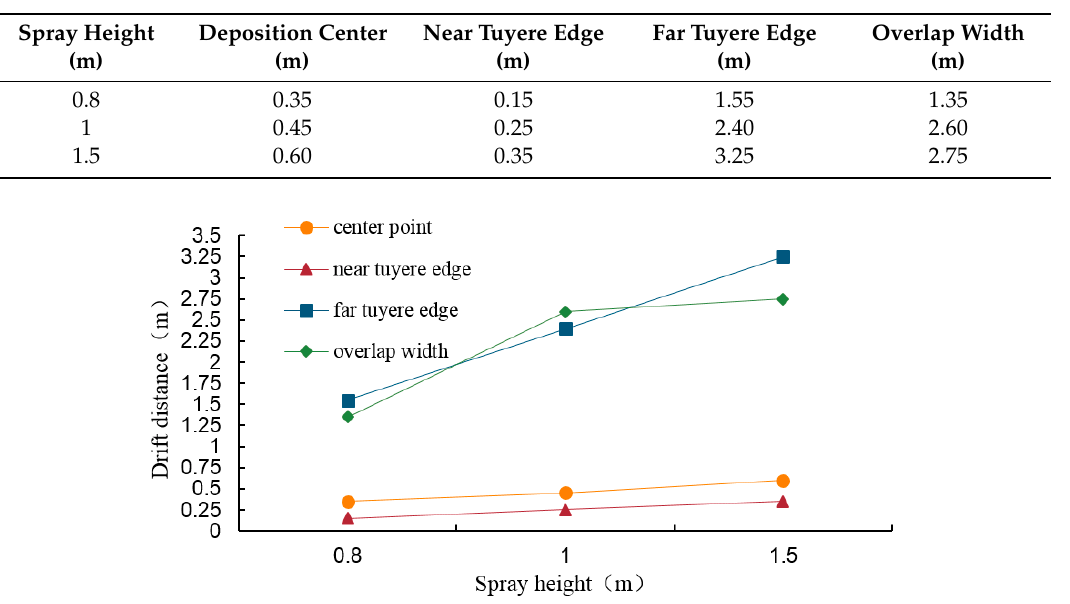
Figure 10. The relationship between spray height and drift distance (center point, near tuyere edge, far tuyere edge, and overlap width).